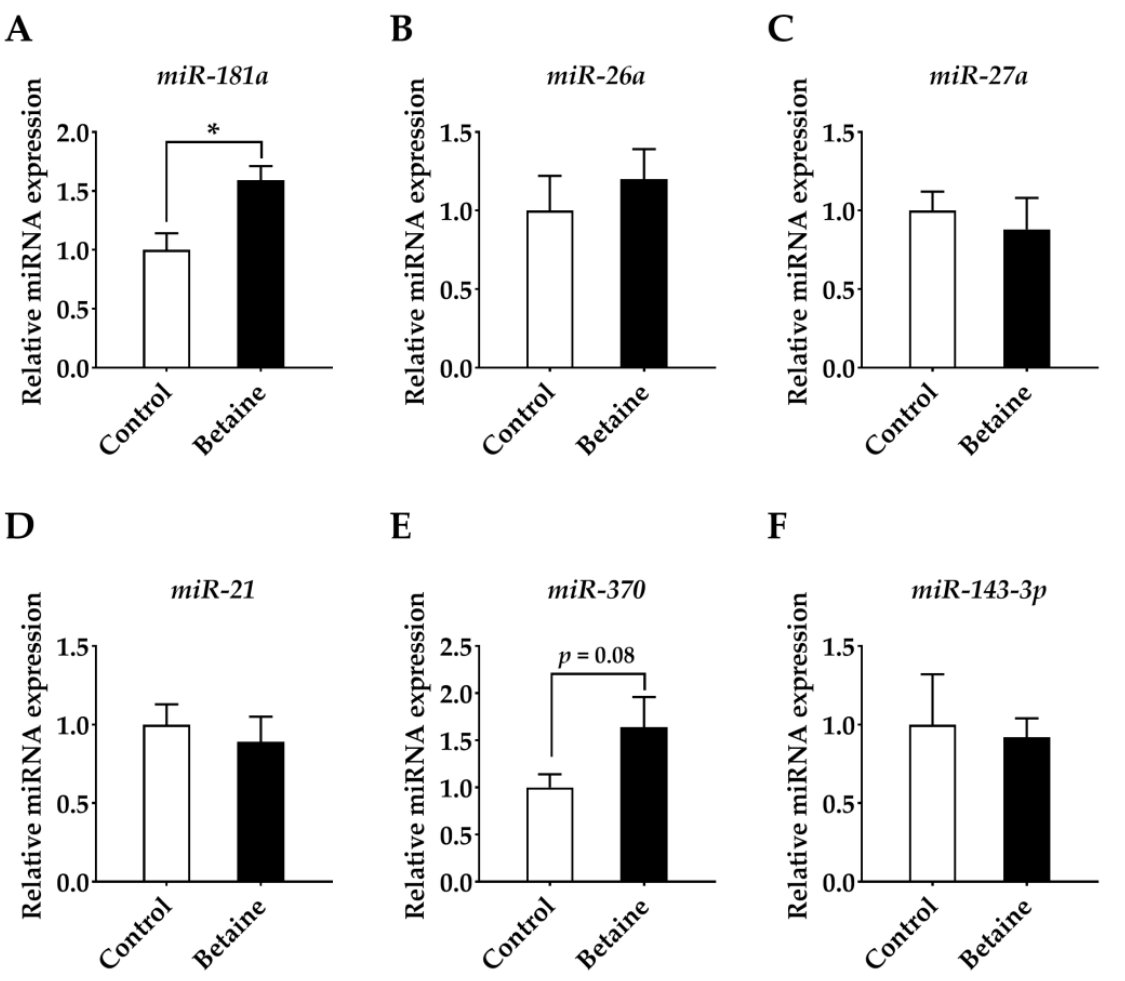
Figure 6. Effects of betaine on microRNA expression in longissimus lumborum muscle of growing- finishing pigs. ( A ) miR-181a ; ( B ) miR-26a ; ( C ) miR-27a ; ( D ) miR-21 ; ( E ) miR-370 ; ( F ) miR-143-3p . * p < 0.05 versus the control group.